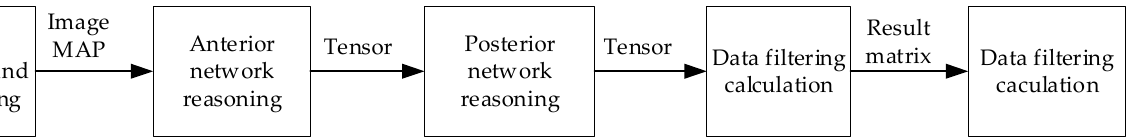
p and p represent the height and width of the w h b indicate the actual width and height of the and h